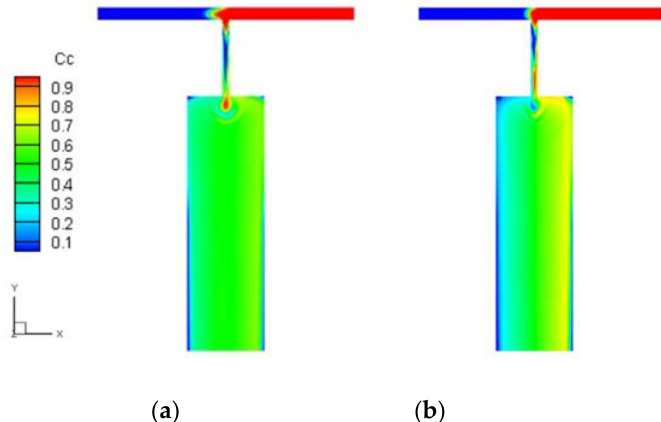
Figure 10. Concentration distribution in viscoelastic fluid case under modulated pressure at both inlets with modulating frequency of f = 1 ( a ) and f = 1.5 ( b ).